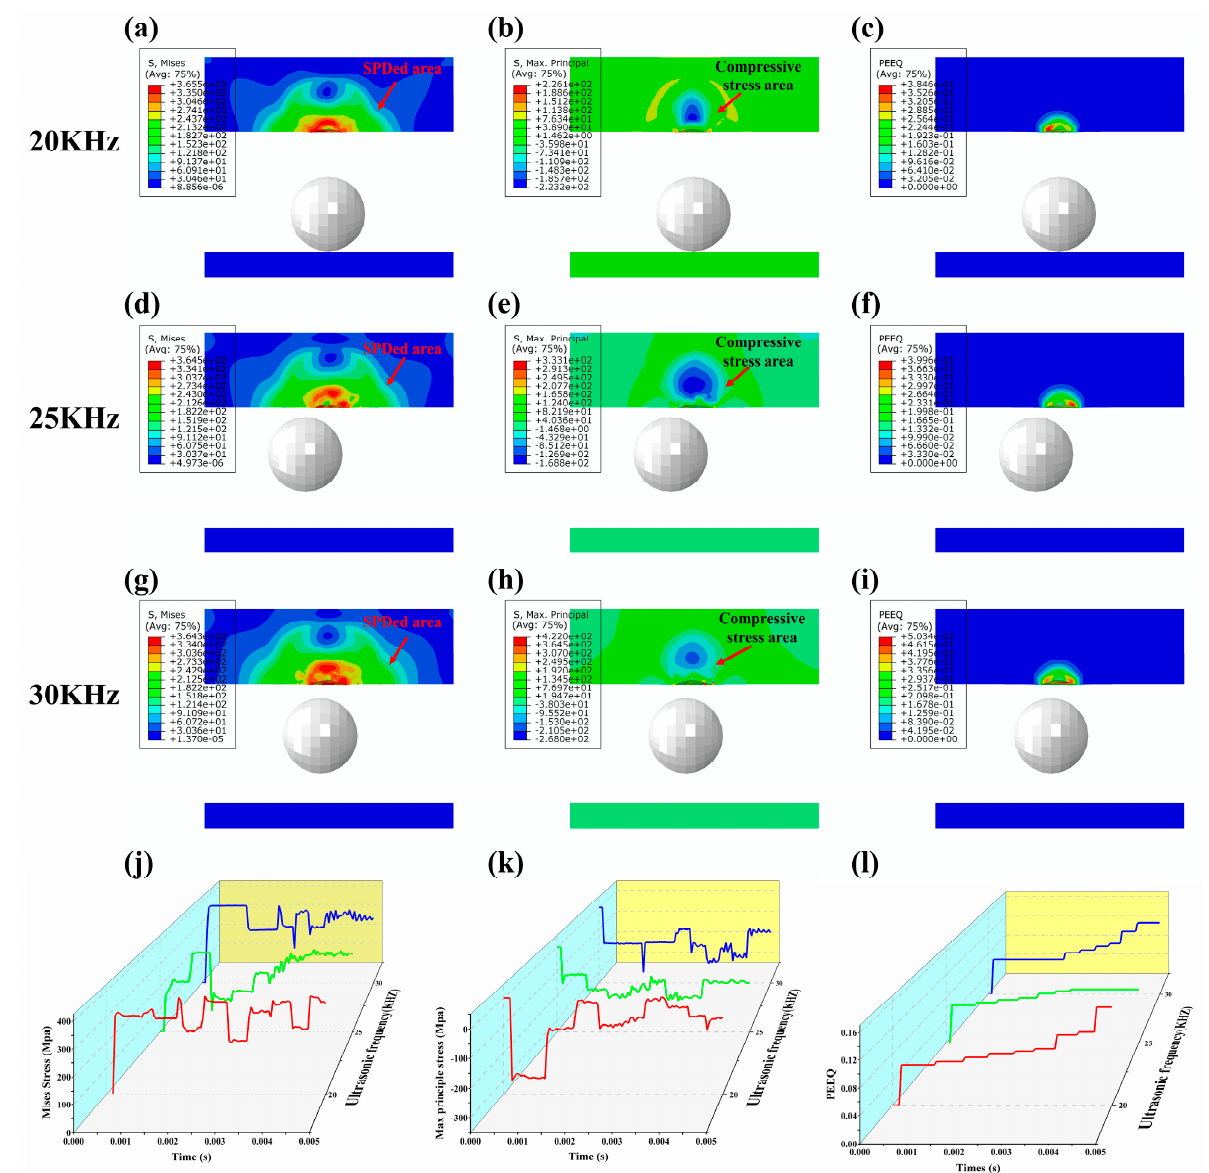
Figure 9. Effect of ultrasonic frequency on von Mises stress, maximum principal stress, and plastic strain of 316L stainless steel during the ultrasonic shot peening process: ( a – c ) von Mises stress, maximum principal stress, and plastic strain of 316L stainless steel with USP frequency of 20 kHz, respectively; ( d – f ) von Mises stress, maximum principal stress, and plastic strain of 316L stainless steel with USP frequency of 25 kHz, respectively; ( e – i ) von Mises stress, maximum principal stress, and plastic strain of 316L stainless steel with USP frequency of 30 kHz, respectively; ( i – l ) comparison of von Mises stress, maximum principal stress, and plastic strain of 316L stainless steel with USP frequency of 20 kHz, 25 kHz and 30 kHz, respectively.